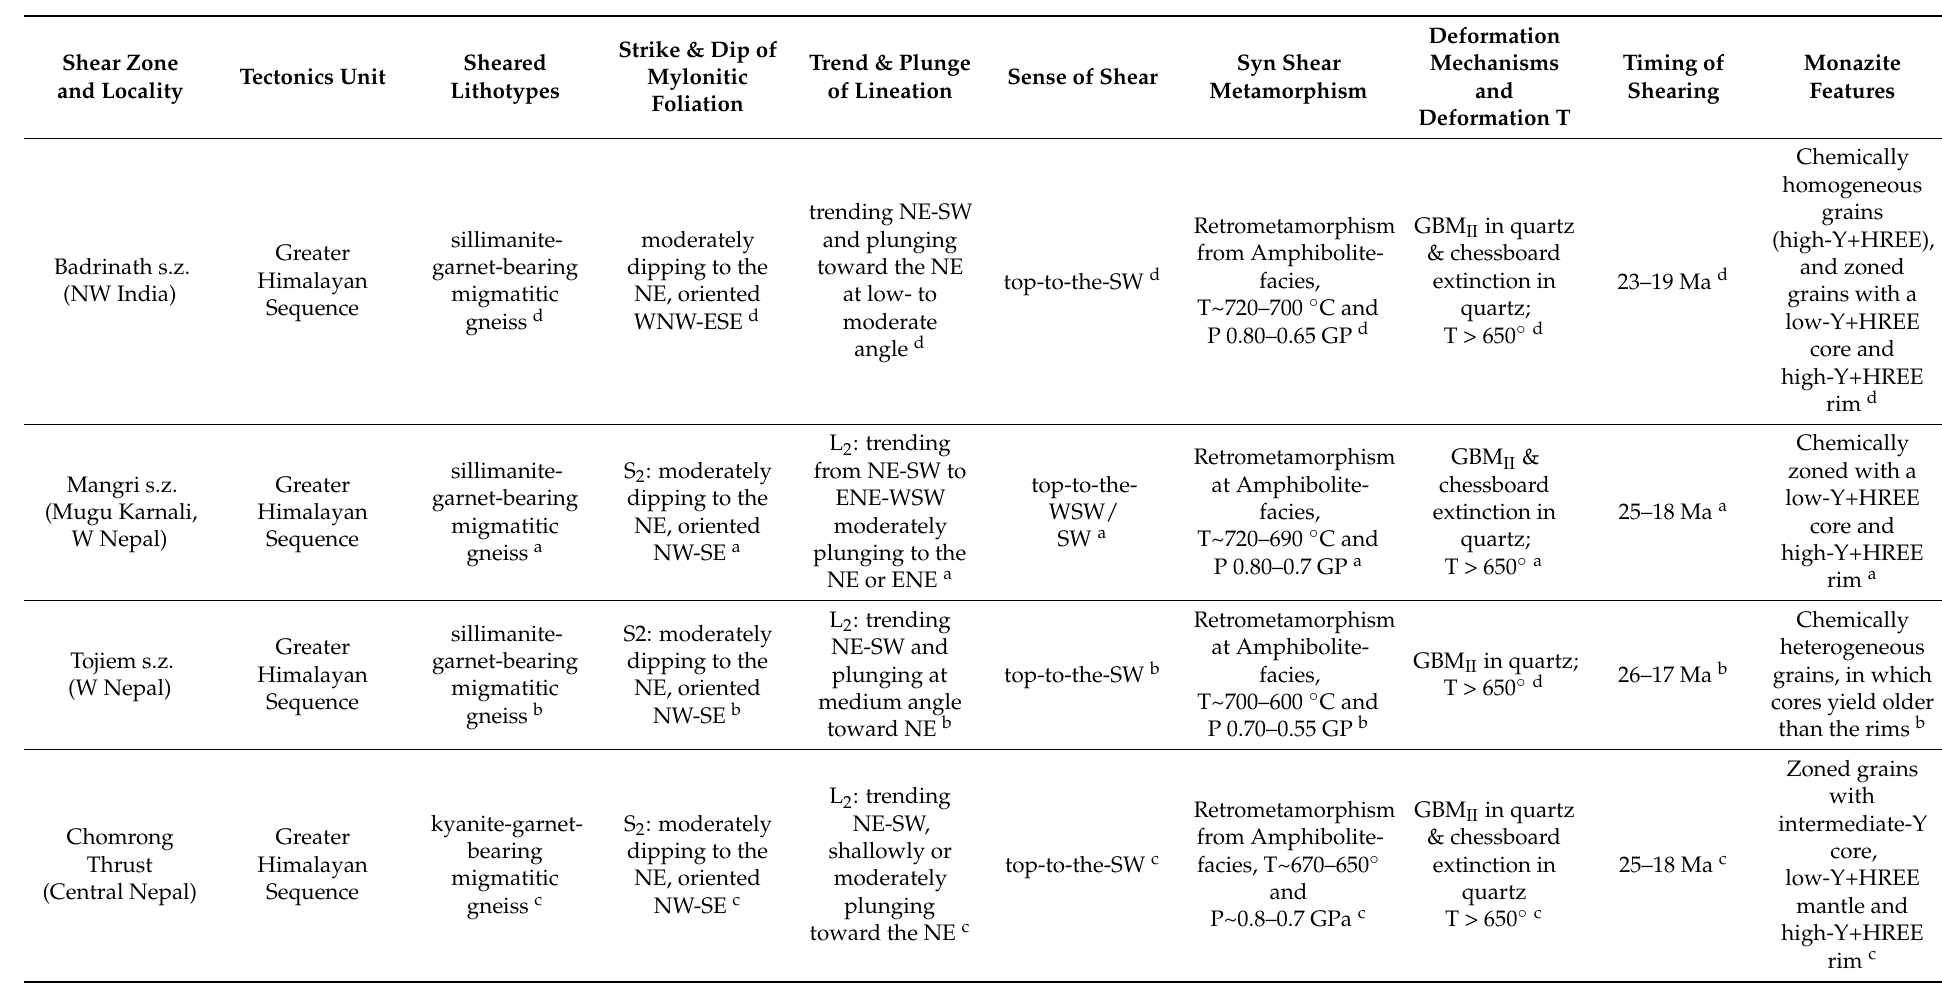
Table 2. Summary of structural and geochronology data sets of the HHD in western Nepal and NW India